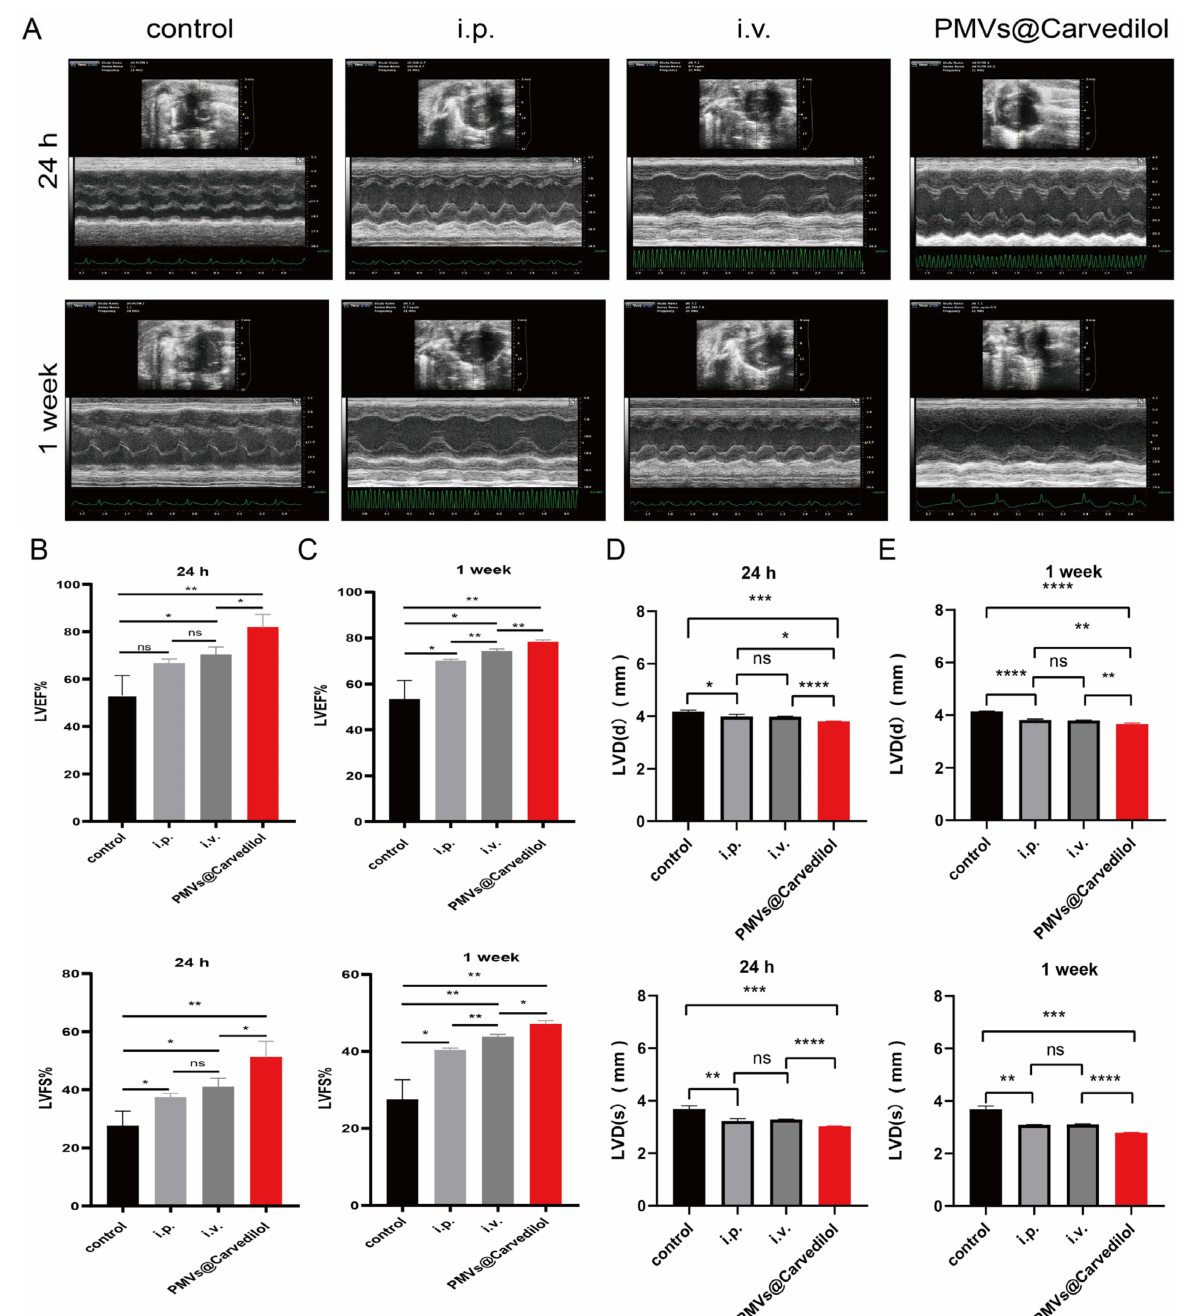
Figure 6. Detection of ultrasound cardiogram in rats from different groups. ( A ) Echocardiography in SD rats 24 h and 1 week after MIRI. ( B ) Quantitative analyses of 24 h heart LVEF% and LVFS%. ( C ) Quantitative analyses of 1 week heart LVEF% and LVFS%. ( D ) Quantitative analyses of 24 h heart LVDd and LVDs. ( E ) Quantitative analyses of 1w heart LVDd and LVDs. (i.p. means intraperitoneal injection; i.v. means intravenous injection.) * p < 0.05; ** p < 0.01; *** p < 0.001; **** p <